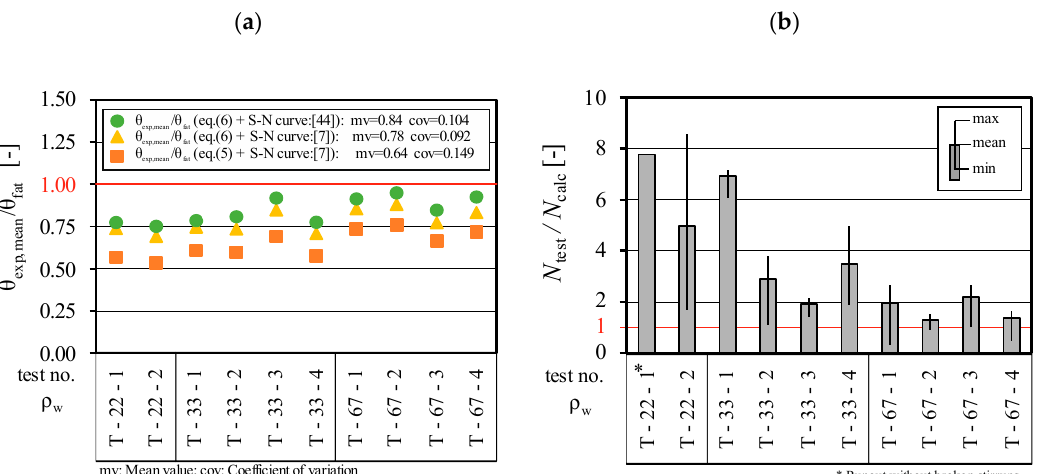
Figure 11. ( a ) Recalculated strut angle for test specimen T-33-2; ( b ) Recalculated strut angles of all T-beams tested.